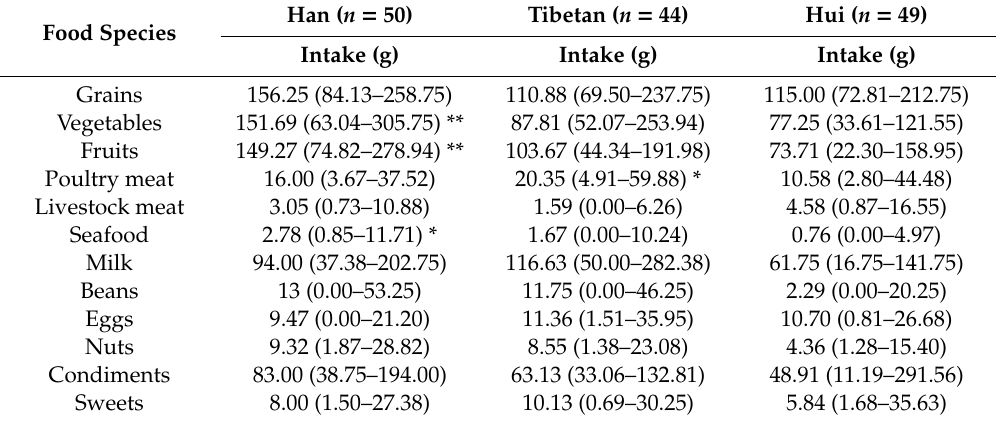
Table 1. Average daily food intake among the three ethnic groups.